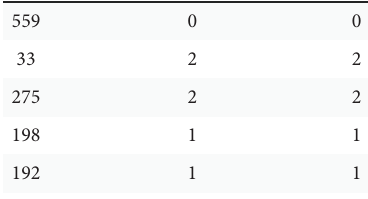
Figure 20: Type classifcation